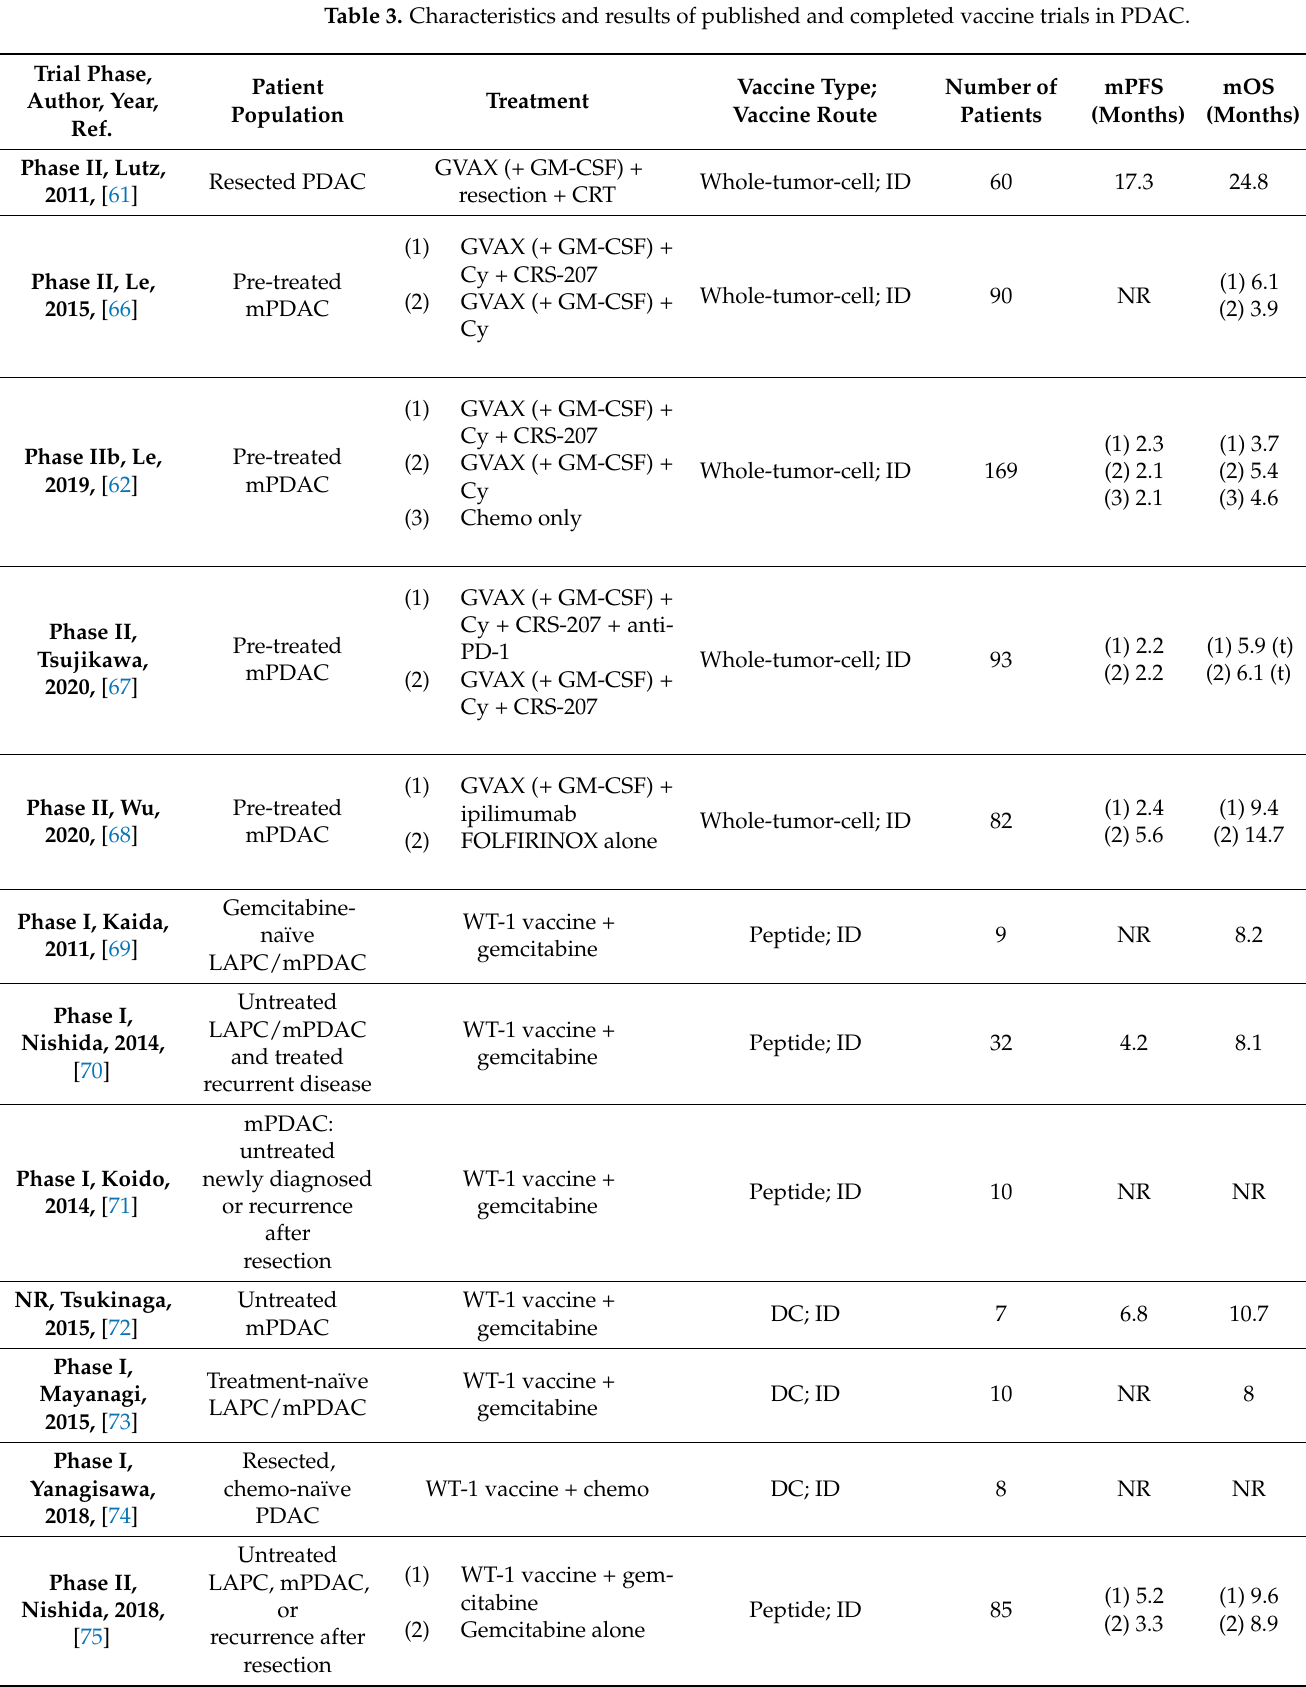
Table 3. Characteristics and results of published and completed vaccine trials in